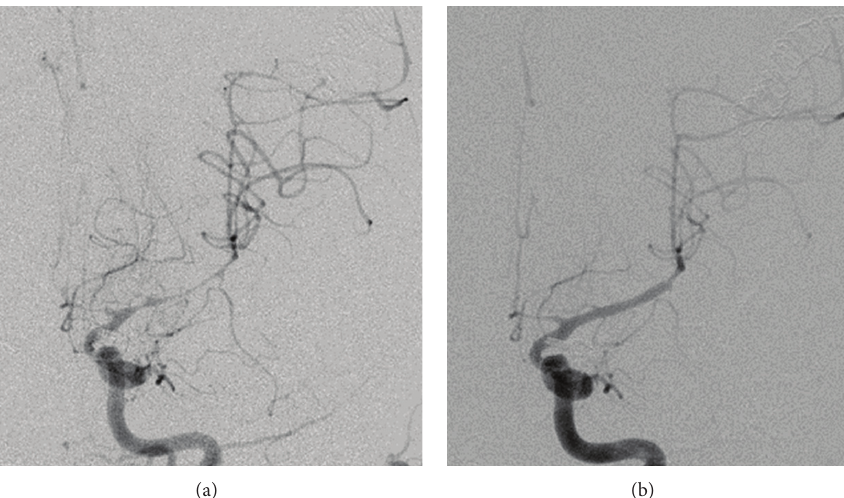
F 3: Digital Subtraction Angiography. Severe vasospasm of the le middle cerebral artery demonstrated on digital subtraction angiography (a). Postangioplasty angiogram demonstrates normal caliber of the native vessel